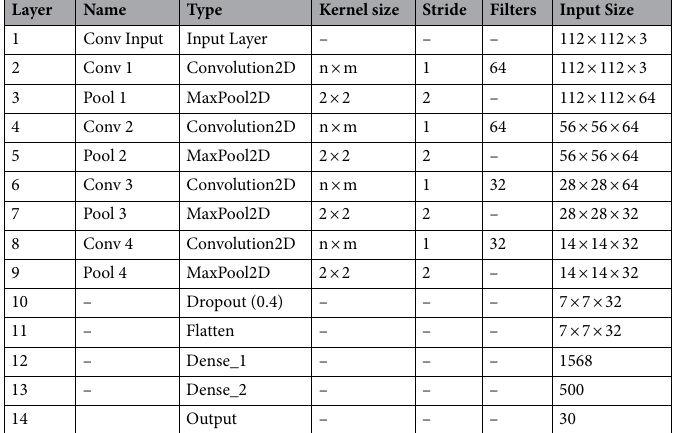
Table 2. CNN model structure